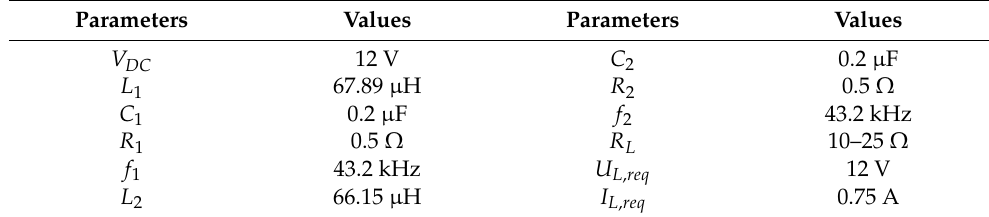
Table 1. WPT system parameters.